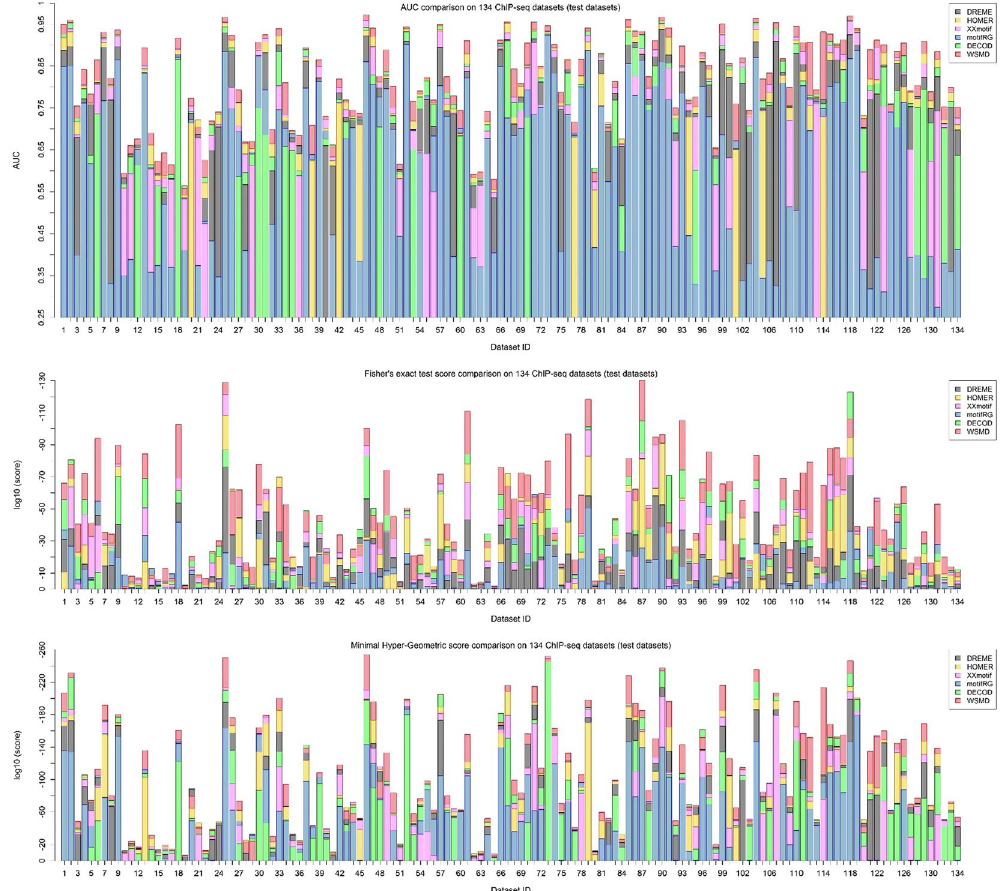
Figure 2. 3-fold cross-validation test performance on three reference-free evaluation criteria over 134 datasets. The performances of six methods on same dataset were plotted on one horizontal bar while differing in colors. In this way, the lines with different colors in one horizontal bar present the performance archived by corresponding tools, and the height of box with different colors can show the performance improvement of corresponding tools compared with the one performing more poorly. ( a ) 3-fold cross-validation test performance on AUC over 134 datasets. ( b ) 3-fold cross-validation test performance on Fisher’s Exact Test score over 134 datasets. ( c ) 3-fold cross-validation test performance on Minimal Hyper-Geometric score over 134